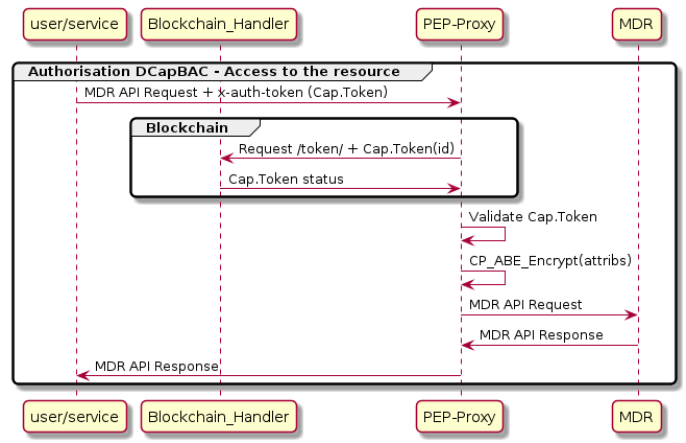
Figure 12. Policy Enforcement Point (PEP) Proxy interaction